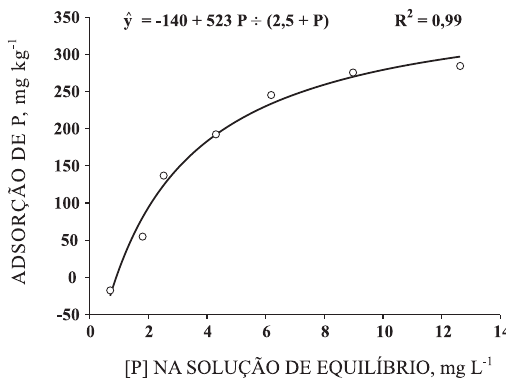
Figura 3. Adsorção de P pelo substrato Plantmax em função da concentração de P na solução de